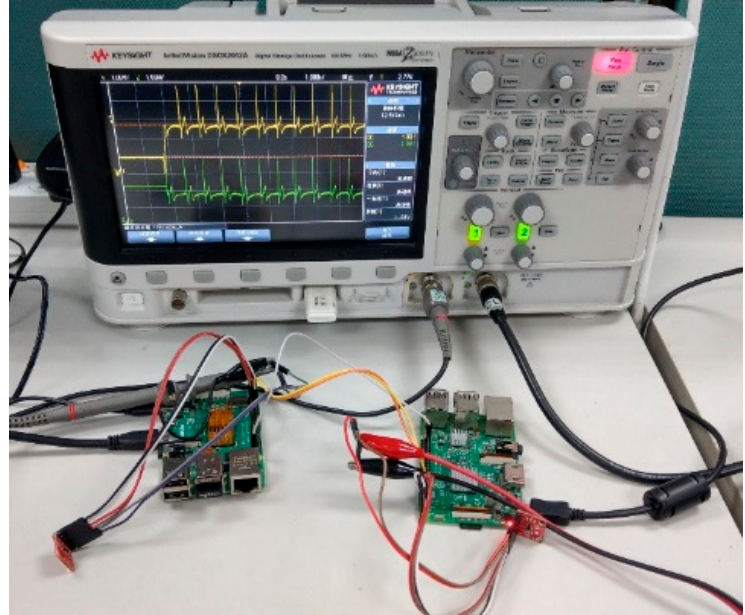
Figure 20. Implementation of the chaos systems.